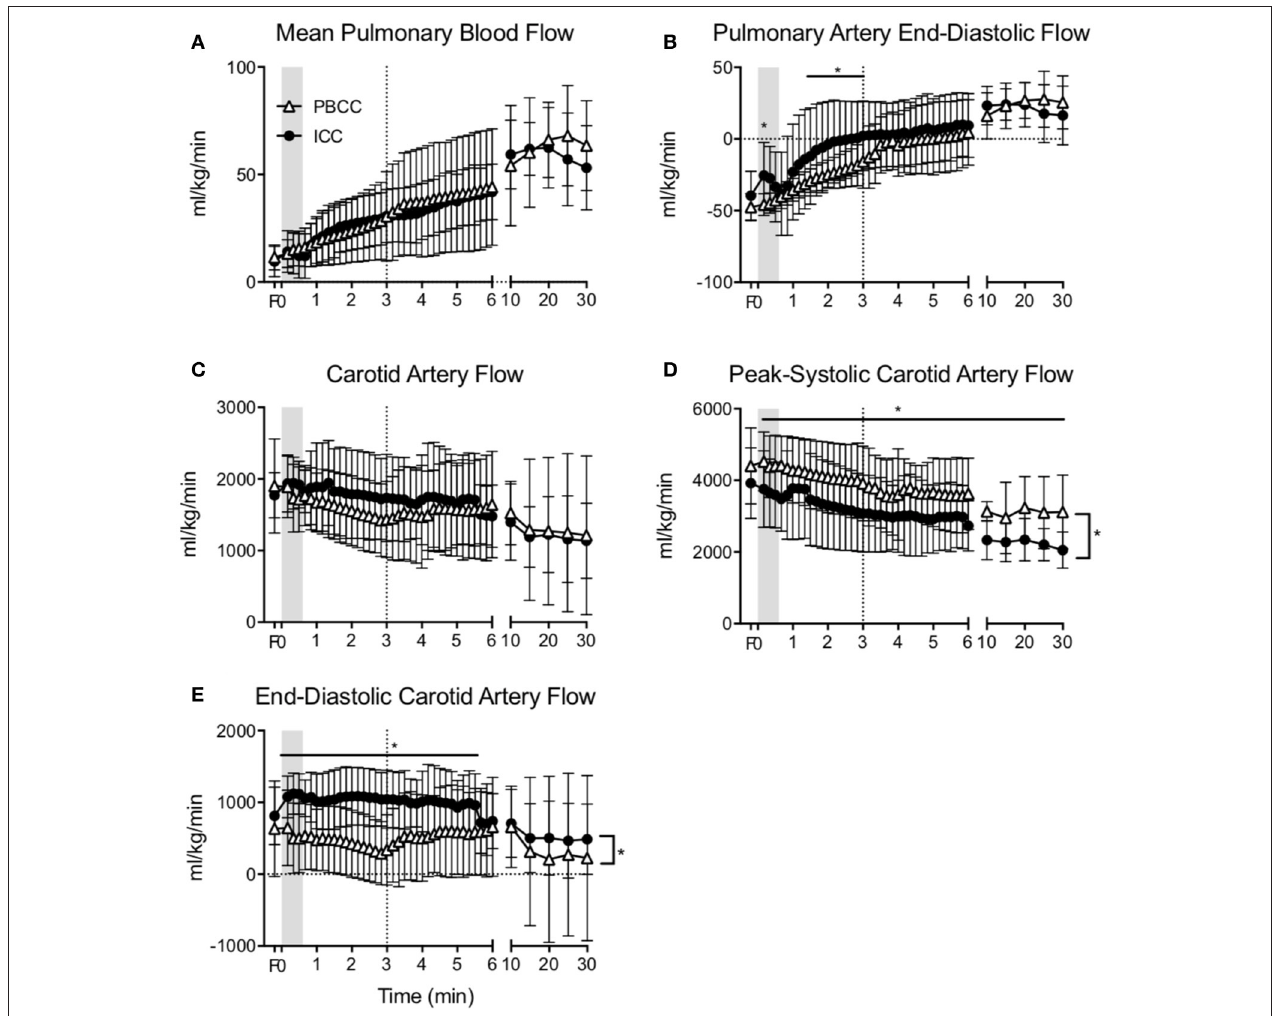
FIGURE 3 | (A) Mean pulmonary blood flow, (B) end-diastolic pulmonary blood flow, (C) mean carotid arterial flow, (D) peak-systolic, and (E) end-diastolic carotid arterial flow measured in PBCC (open triangles) or ICC (closed circles) preterm lambs exposed to antenatal LPS for 7 days. Shaded region indicates the time between cord clamping and ventilation onset in ICC lambs. Dashed line represents time of cord clamping in PBCC lambs. *indicates significant difference between groups.